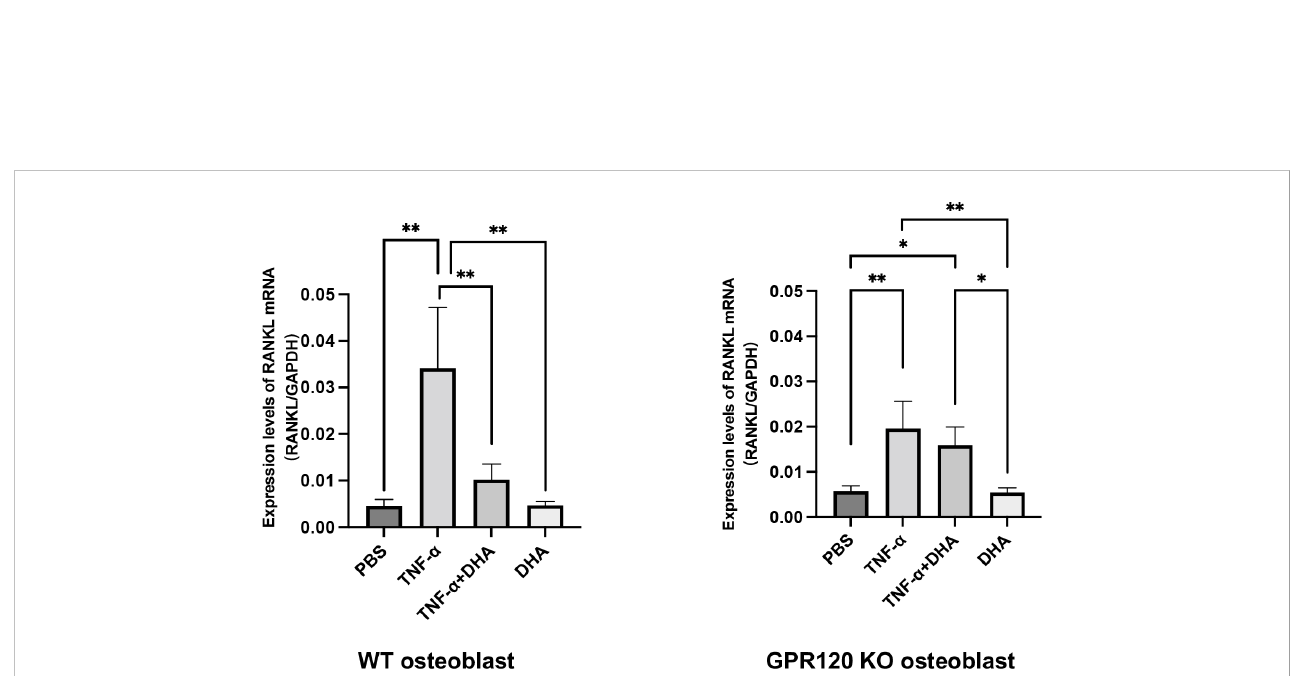
FIGURE 3 DHA inhibited RANKL expression in osteoblasts via GPR120 in vitro . RANKL mRNA levels of osteoblasts were demonstrated using real-time RT-PCR. Osteoblasts of WT and GPR120-KO mice were cultured with PBS, TNF- a , TNF- a + DHA, or DHA only. The results are given as means ± SD. Scheffe ́ ’ s test was used to determine the statistical signi fi cance of differences (n = 4; * p < 0.05, ** p < 0.01).